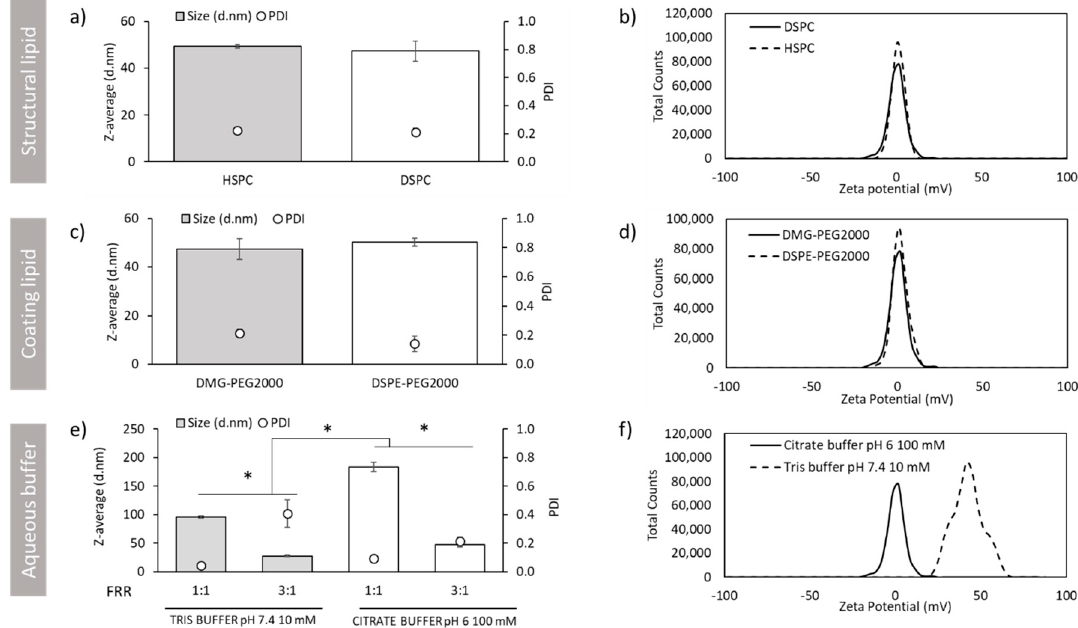
Figure 5. Effect of the structural lipid, the coating lipid and the aqueous buffer choice in the production of cLNPs based on DOTAP after purification via dialysis. ( a ) Particle size (bars) and PDI (open circles) and ( b ) zeta potential intensities of the cLNPs produced using HSPC (grey) or DSPC (white) as structural lipid. ( c ) Particle size (bars) and PDI (open circles) and ( d ) zeta potential intensities of the cLNPs produced using DMG-PEG2000 (grey bar) or DSPE-PEG2000 (white bar) LNPs. ( e ) Particle size (bars) and PDI (open circles) and ( f ) zeta potential intensities of the cLNPs produced using TRIS buffer pH 7.4 10 mM (grey) or citrate buffer pH 6 100 mM as production buffer. Unless otherwise stated, all the formulations were prepared at 20 mL/min TFR, 3:1 FRR and using citrate buffer as production buffer (pH 6, 100 mM). Results represent the mean of at least 3 independent batches and the standard deviation is plotted as error bars. Significant differences are shown as * p < 0.05.